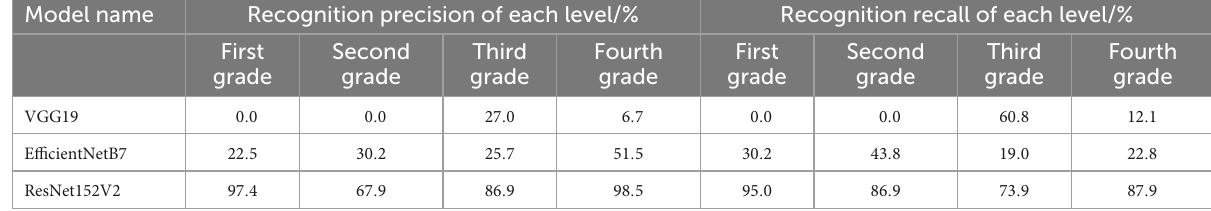
TABLE 3 Test results of the three